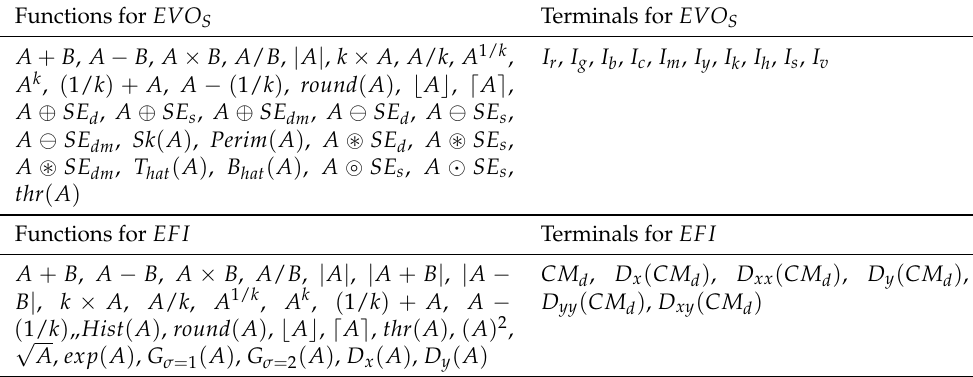
Table 1. Cont . Functions for EVO S Terminals for EVO